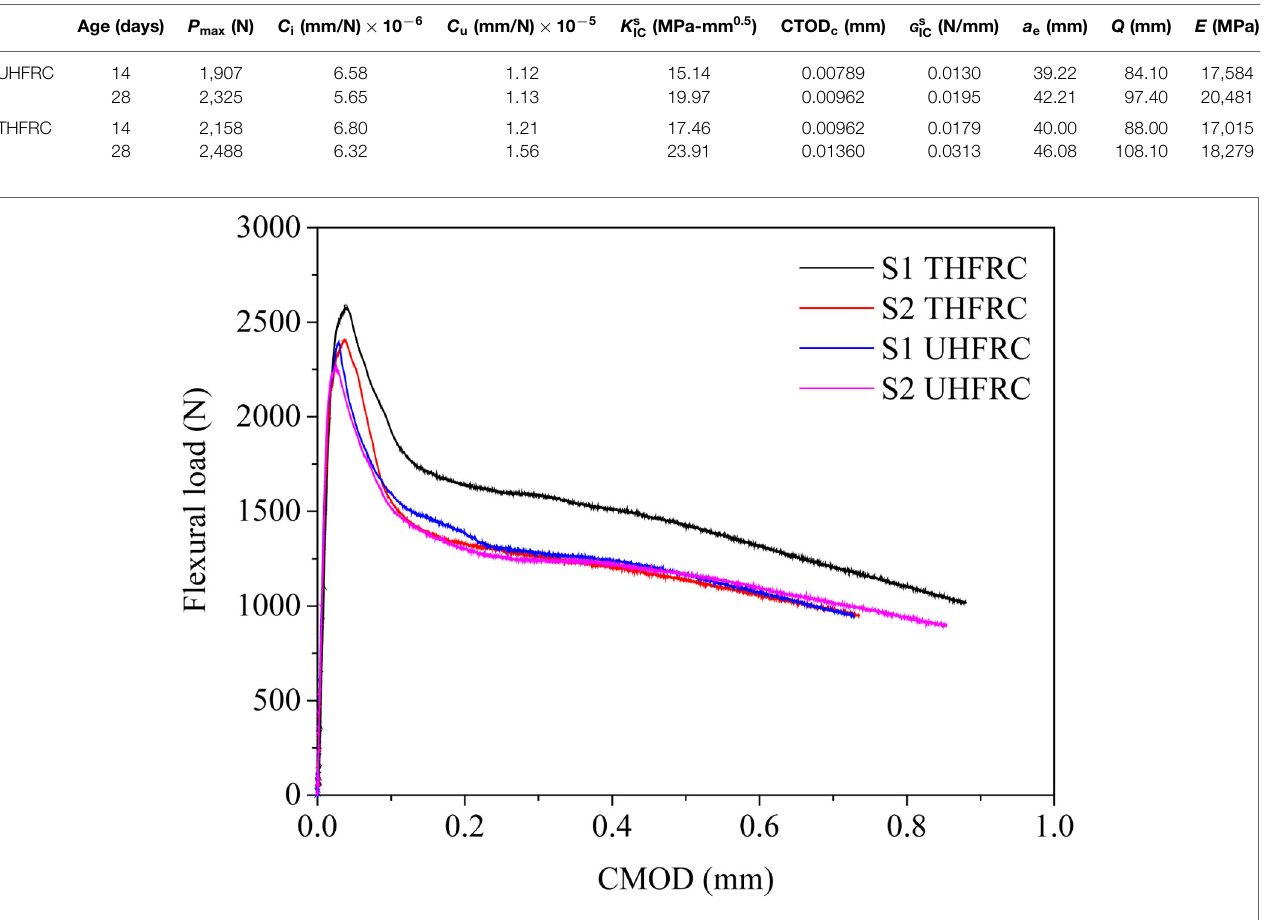
FIGURE 6 | Comparison of load vs. CMOD for UHFRC and treated hemp fiber-reinforced concrete (THFRC) at 28days.